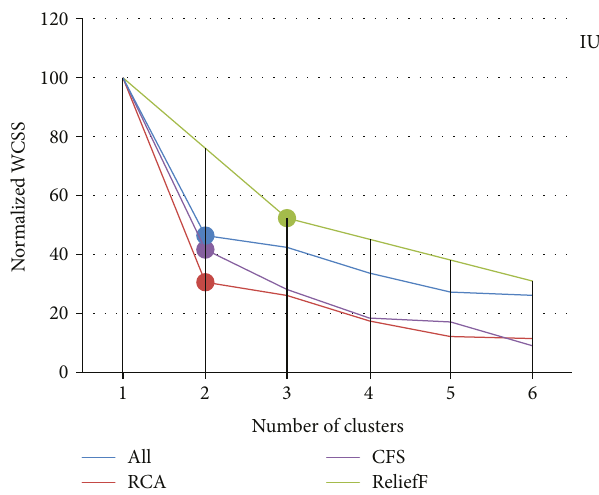
Figure 3: Validation of clustering for the IUGR dataset.